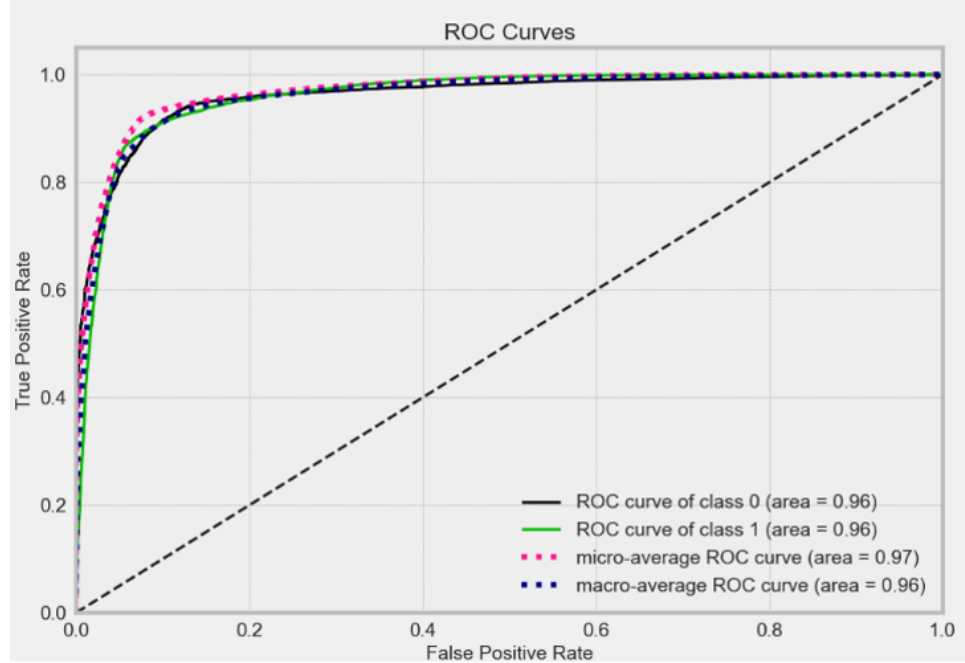
Figure 19. ROC Curves for random forest model.